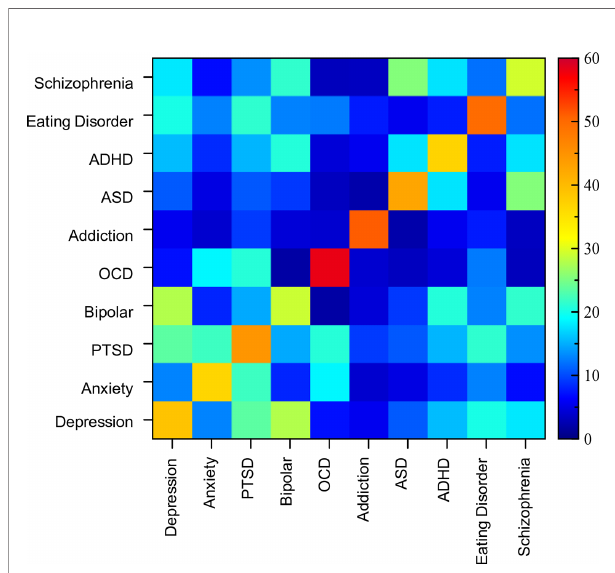
FIGURE 5 | Matrix of similarity scores. Symmetric matrix of similarity scores between assessment tools both within and between disorders. Diagonal indicates within disorder similarity comparisons and ranged from 29% (bipolar) to 58%